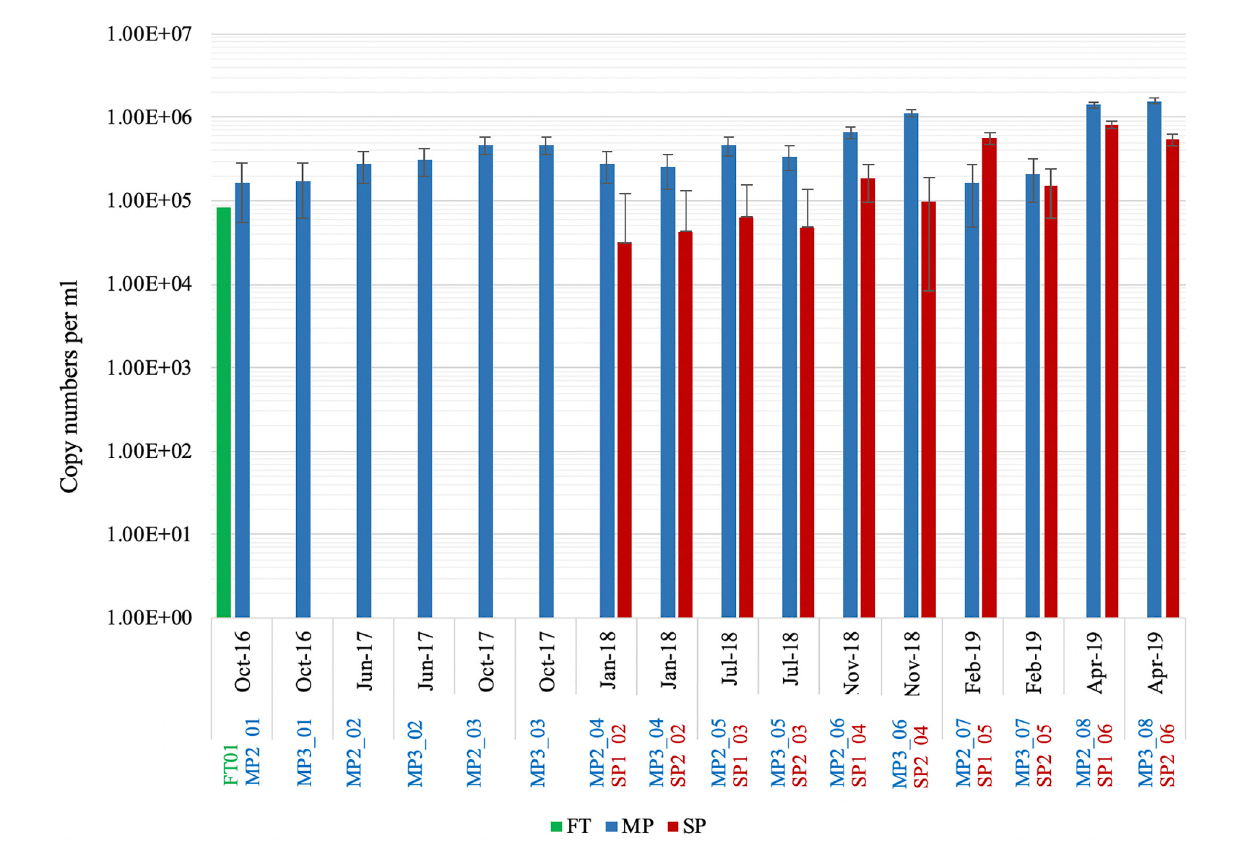
FIGURE 2 | QPCR results show the average number of copies per mL per sampling site and time (FT: feeding tank, MP: main ponds and SP: subponds). Copy numbers are expressed on log scale and error bars represent standard error. Missing bars represent lack of samples for certain sampling dates (FT and SP). A standard curve for QPCR reaction was calculated at concentration ranging from 7.53 × 10 − 4 to 7.530 × 10 3 ng mL − 1 (2.8 × 10 3 − 2 . 8 × 10 12 DNA copies) to estimate the concentration of DNA in the